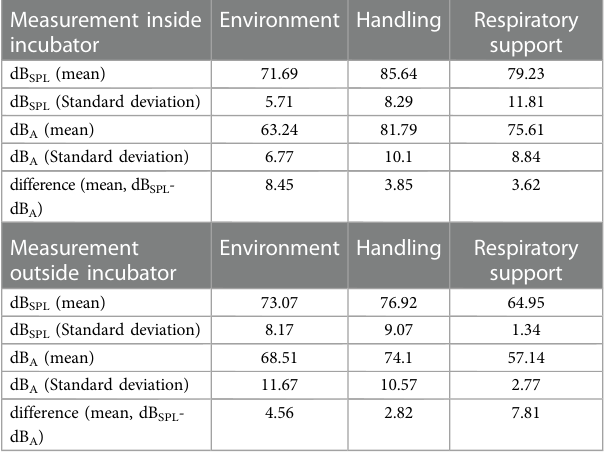
TABLE 2 Mean values and standard deviations as well as the difference of the mean values between the measured dB SPL and dB A values. Measurement inside